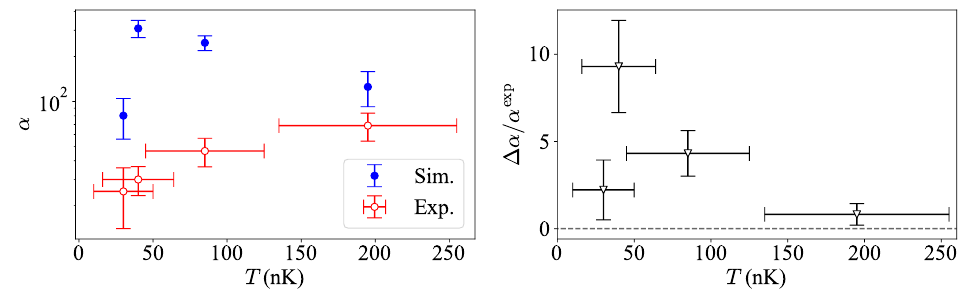
Figure 8: The sensitivity of the decay timescale τ to small changes in barrier height, characterised by the fit parameter α , as a function of temperature. (Left) Comparison between the value calculated from the simulations α sim (blue filled circles) and exper- imental data α exp (red open circles). While the experimental results show the sensi- tivity monotonically increasing with temperature, the simulation trend qualitatively differs. (Right) The relative discrepancy between the simulation and the experimen- tal values, ∆ α = α sim − α exp . The dashed horizontal line illustrates ∆ α = 0. The dis- crepancy is greatest for T = 85nK and least for the highest temperature T = 195nK. Error bars give a 95% confidence interval.